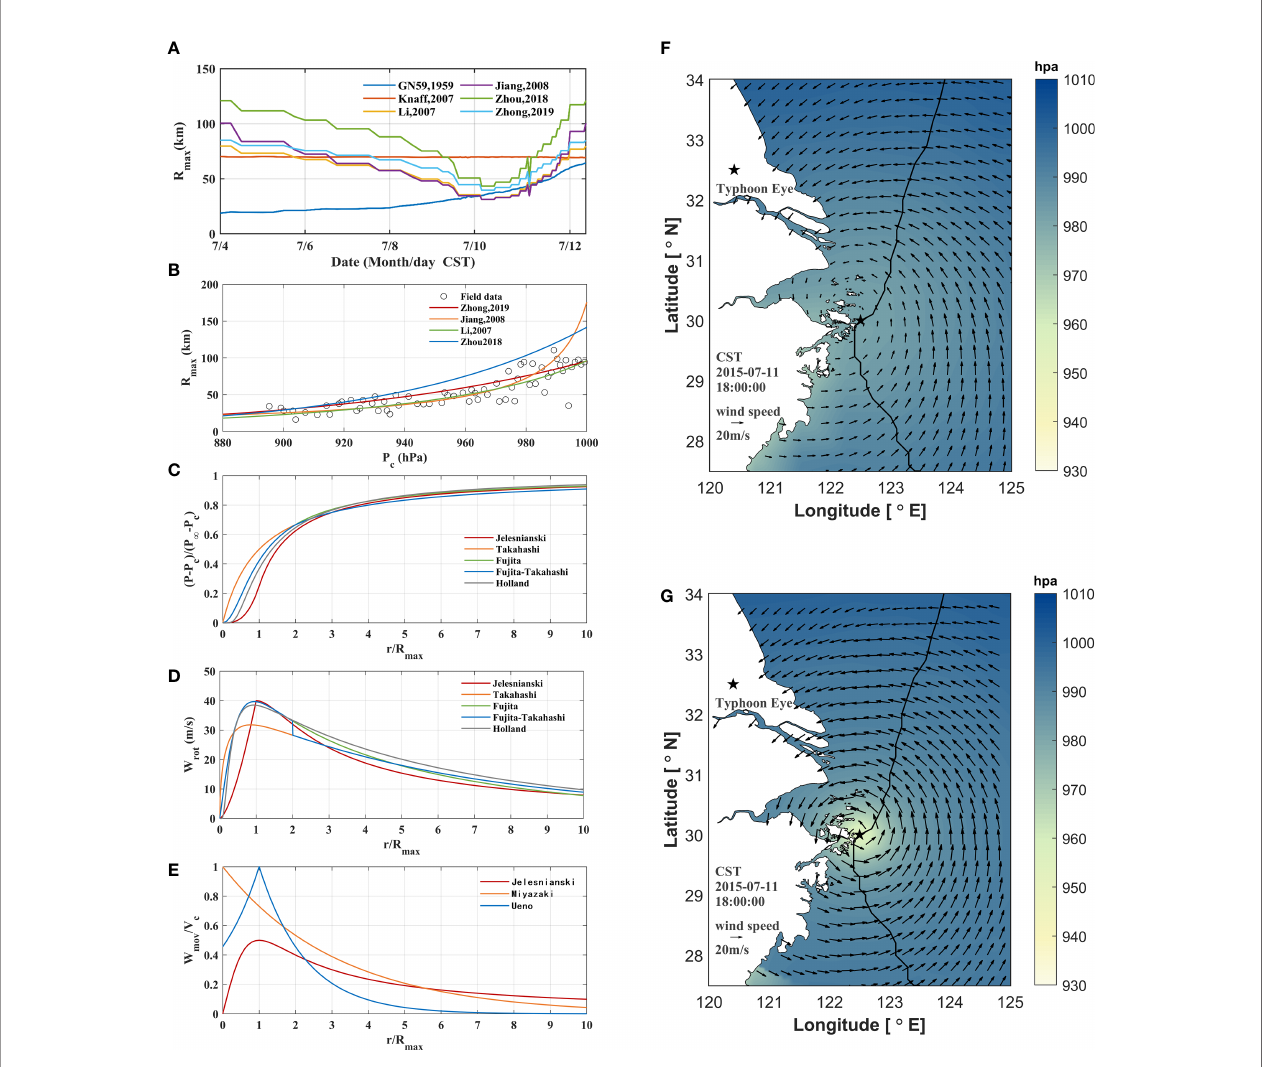
FIGURE 2 | (A) Temporal variation of the maximum wind-speed radius R max calculated through different empirical formulas. (B )Veri fi cation of maximum wind-speed radius R max calculated by different empirical formulas. (C) Comparison of pressure fi elds in different models. (D) Contrast of rotating wind fi eld in different models. (E) Comparison of moving wind fi eld in different models. (F) ECMWF wind fi eld at 18:00 on July 11, 2015 (CST, which is China Standard Time). (G) Reconstructed wind fi eld at 18:00 on July 11, 2015